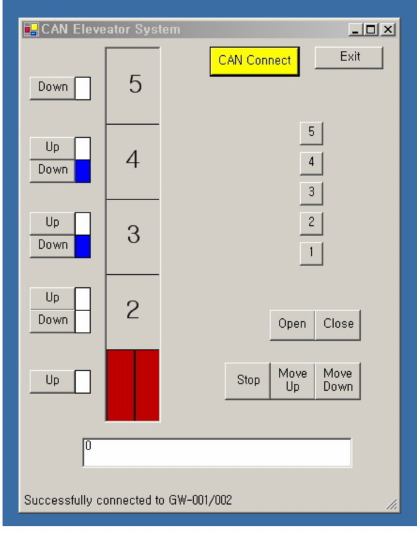
Figure 7. Screenshot of the elevator